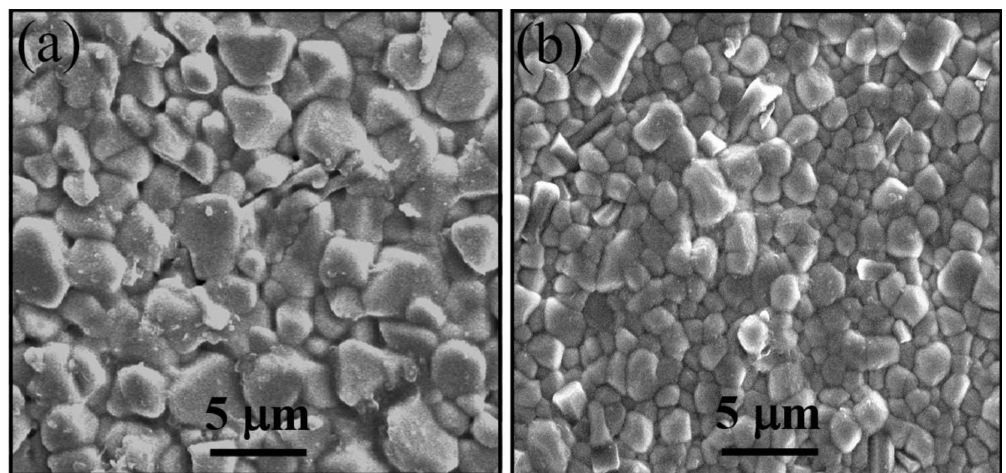
Figure 6. Surface FE-SEM micrographs of ( a ) S1 and ( b ) S2